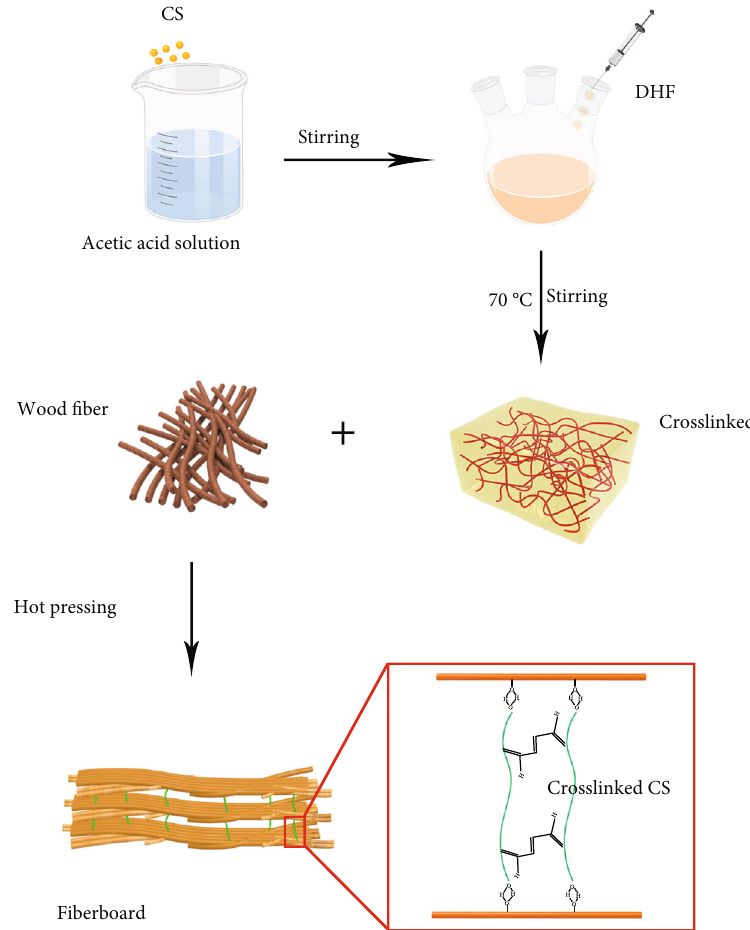
Figure 1: Schematic illustration of the fabrication of fi berboard bonded by DHF cross-linked CS.